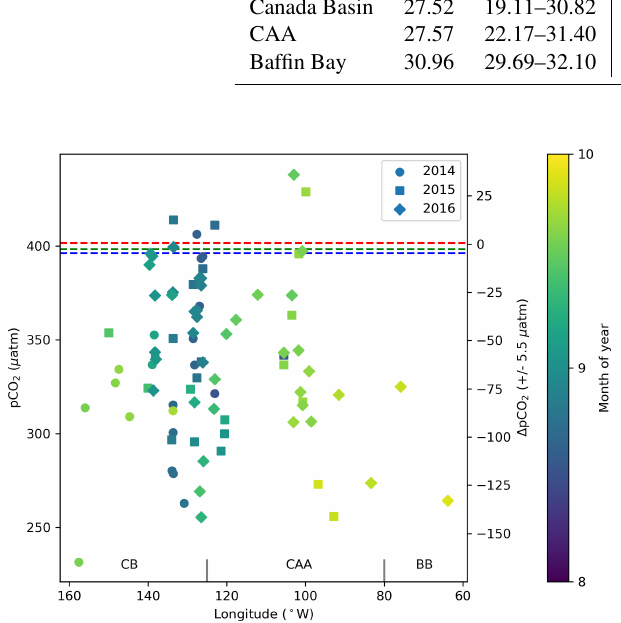
Figure 3. Surface water ( < 5m) p CO 2 and (cid:49)p CO 2 ( p CO 2SW – p CO 2air ) from 2014, 2015 and 2016 in the Canada Basin (CB), Canadian Arctic Archipelago (CAA) and Baffin Bay (BB). The dashed blue, green and red lines represent the average of the global mean monthly atmospheric p CO 2 values for August and September 2014, 2015 and 2016, respectively (data from Dlugo- kencky and Tans, NOAA/ESRL, https://www.esrl.noaa.gov/gmd/ ccgg/trends/ last access: 28 March 2019). The (cid:49)p CO 2 axis shifts in accordance with the atmospheric value used for each year, such that points may be offset from their true position by up to 5.5µatm.